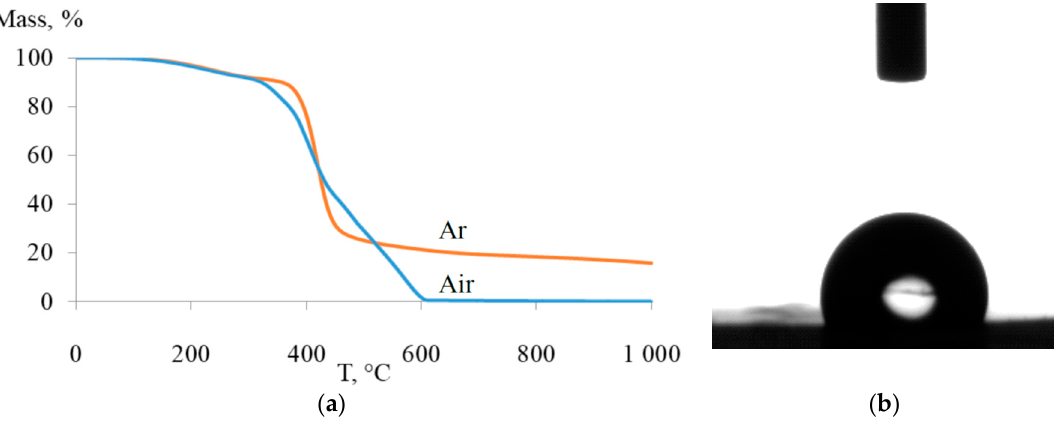
Figure 5. ( a ) TGA curves and ( b ) typical water contact angle for poly(3-pentafluorophenyltricyclononene-7) (APF5).